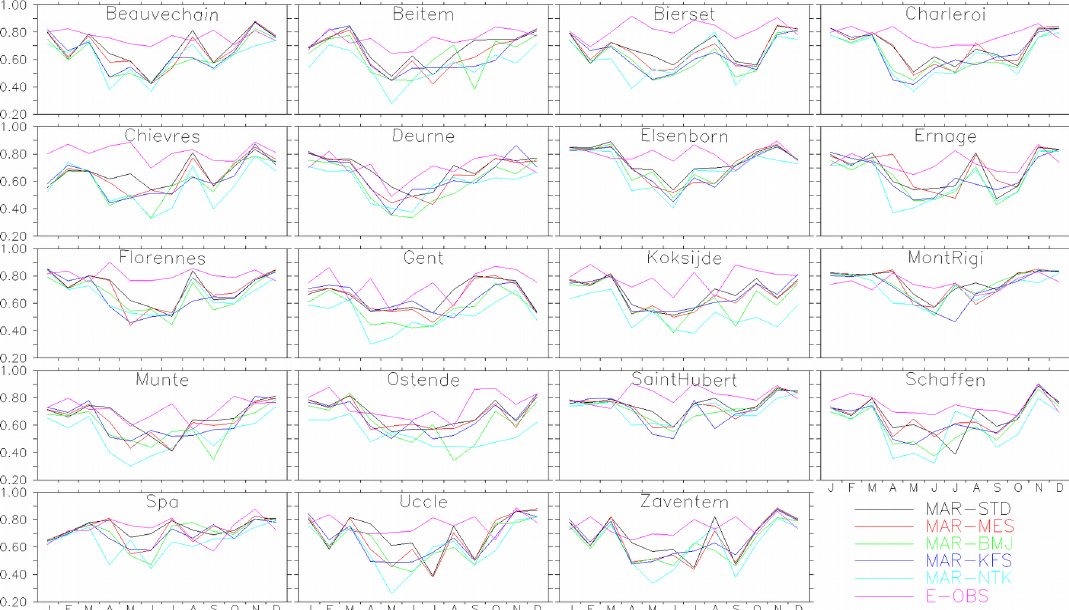
E-OBS with respect to SYNOP